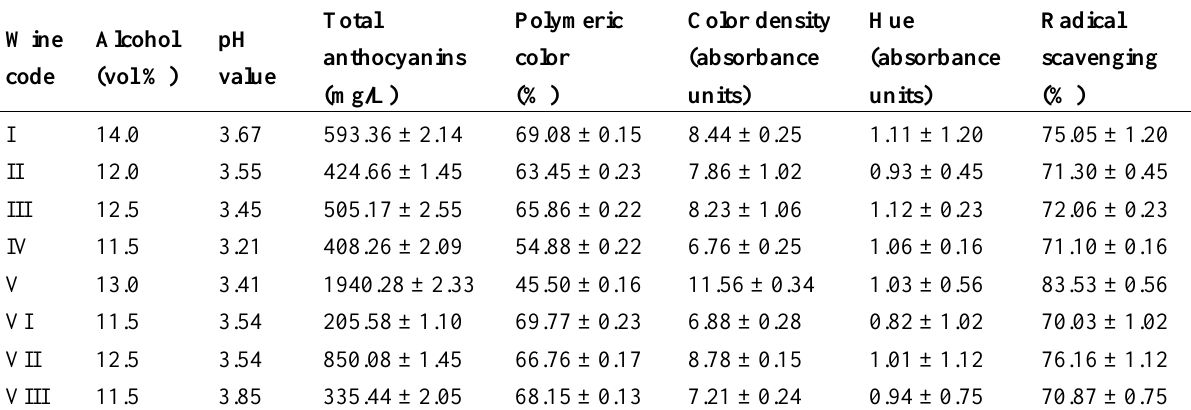
Table 2. Some analytical data, content of anthocyanins and radical scavenging activity of the wine